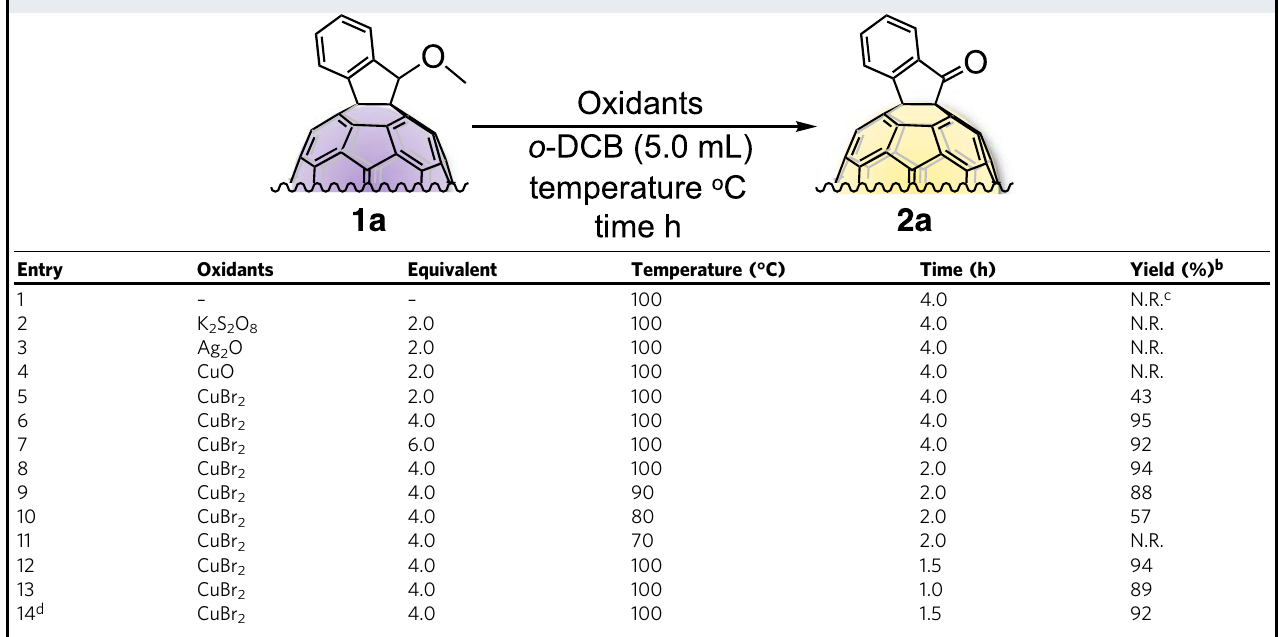
Table 1 Optimization of reaction conditions a